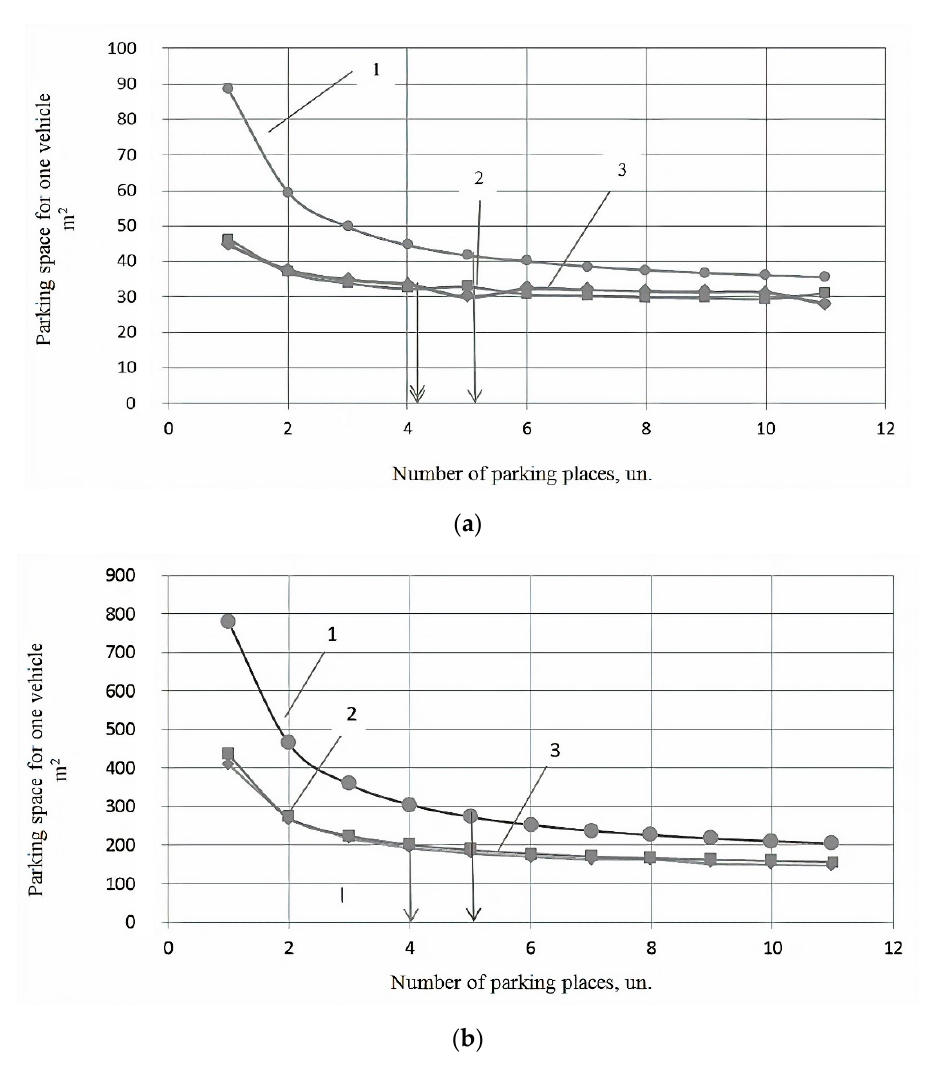
Figure 9. The dependence of the area of the parking space on the number of parking spaces for passenger cars ( a ) and for a 16.5 m long road train ( b ) when set at the corners: 1–90°; 2–60°; 3–45°.